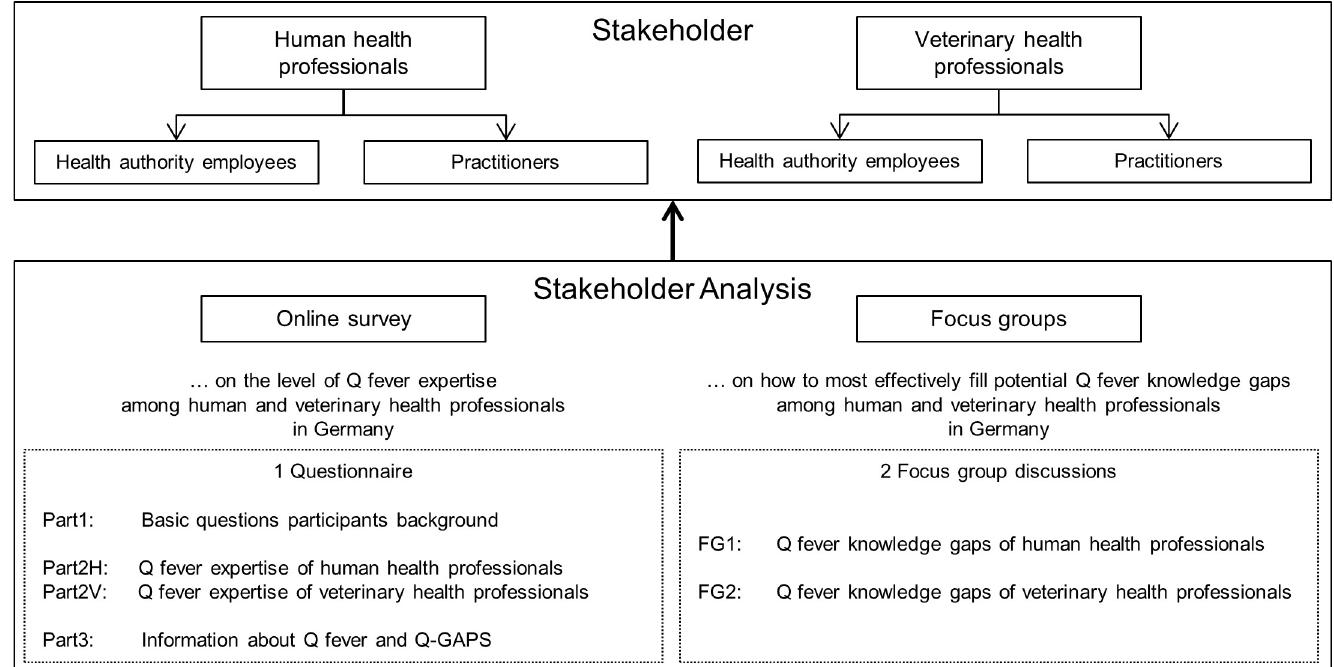
Fig 1. Methodology of this stakeholder